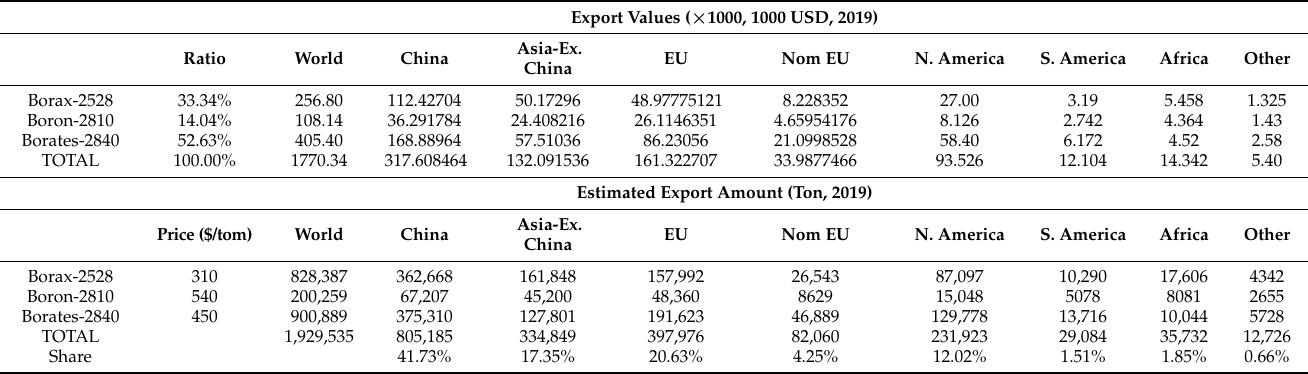
Table 2. Turkey’s boron export for the year of